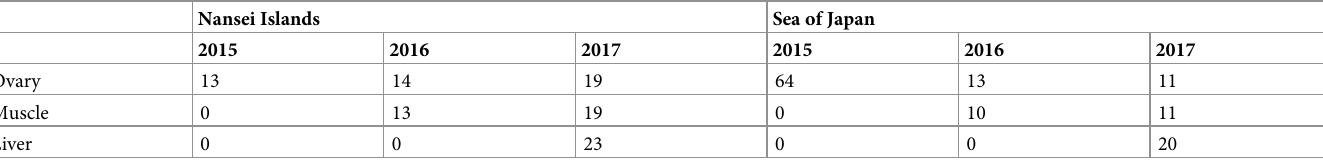
Table 1. Number of samples for each tissue by sampling area and